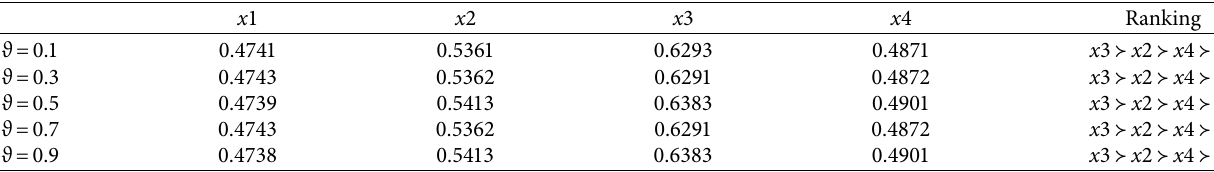
Table 22: .e score for each alternative with different ϑ .